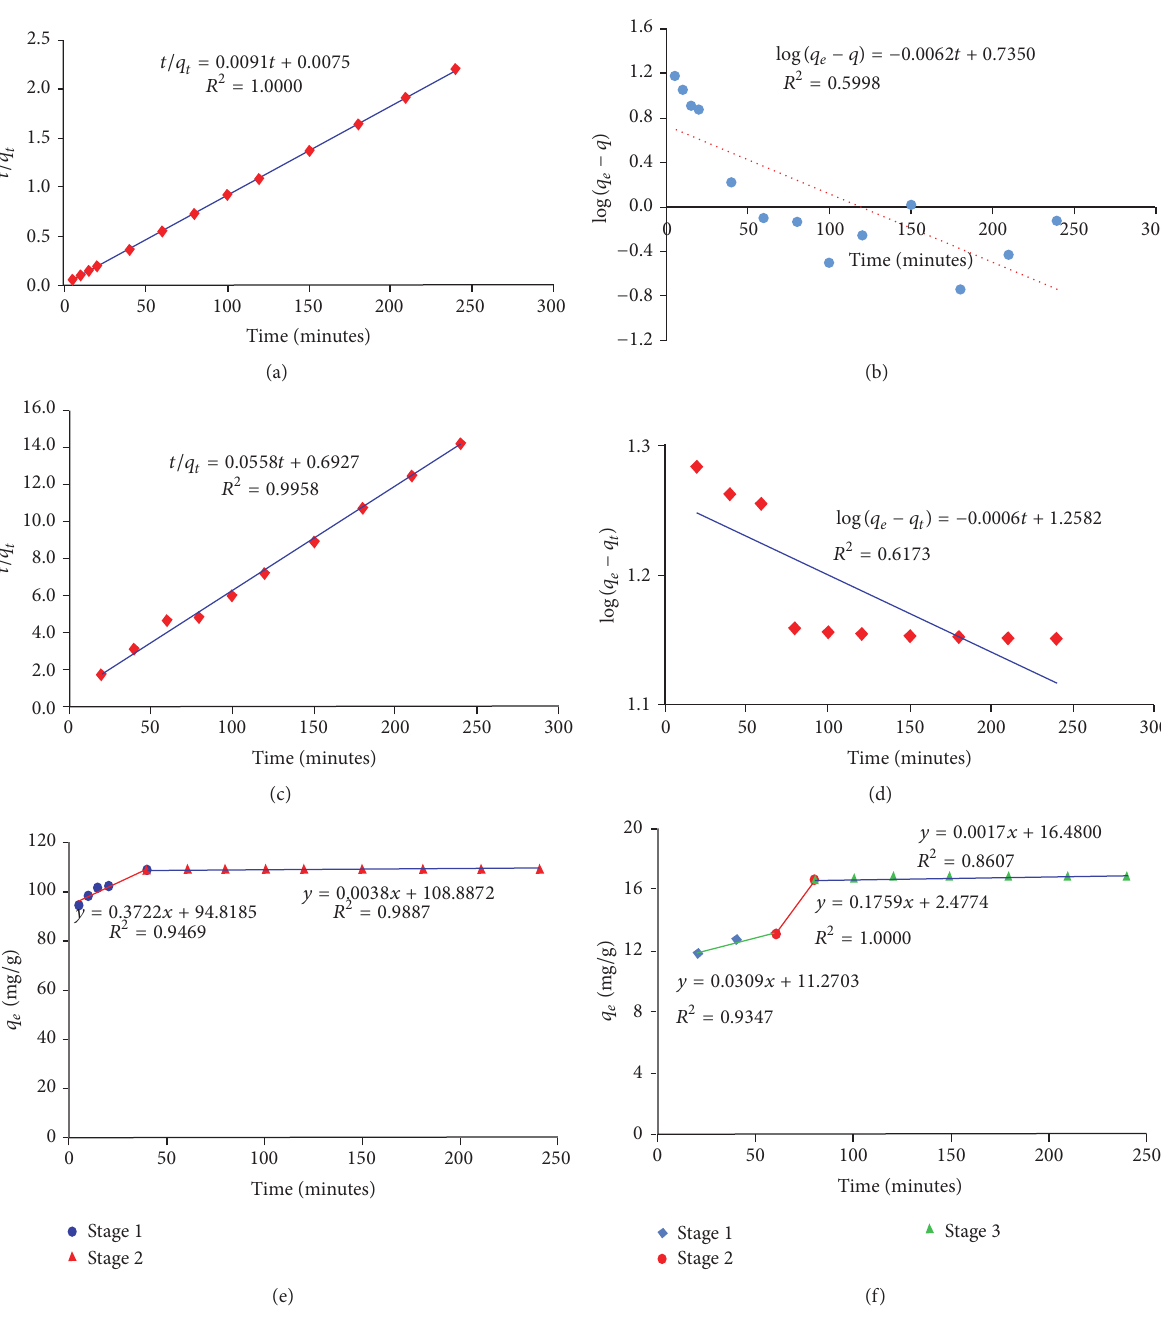
Figure7:Pseudo-first-orderkineticplotsfortheadsorptionofPb(II)(a)andFe(III)(c).Pseudo-second-orderkineticplotsfortheadsorption of Pb(II) (b) and Fe(III) (d). Intraparticle diffusion kinetic plots for the adsorption of Pb(II) (e) and Fe(III)